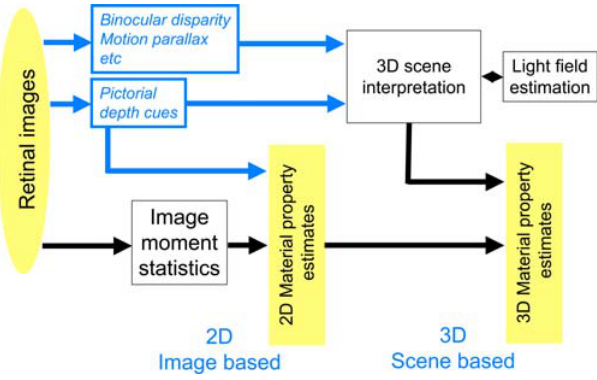
Figure 11. Two-stage model for material property perception The first stage (2D) makes use of pictorial cues including simple statistics such as image moments to estimate material properties including lightness. The second stage (3D) makes use of available depth cues to estimate scene layout and the light field and to further correct material property estimates based on the estimates of scene layout and light field. See text.